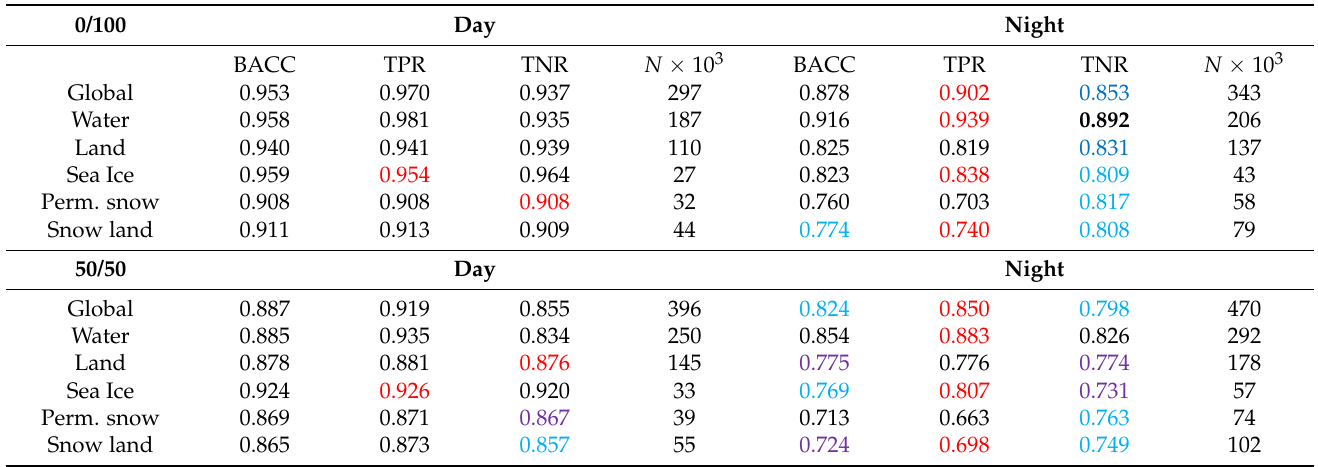
Table 7. Balanced accuracy method metrics for CV1S detection computed for different surface